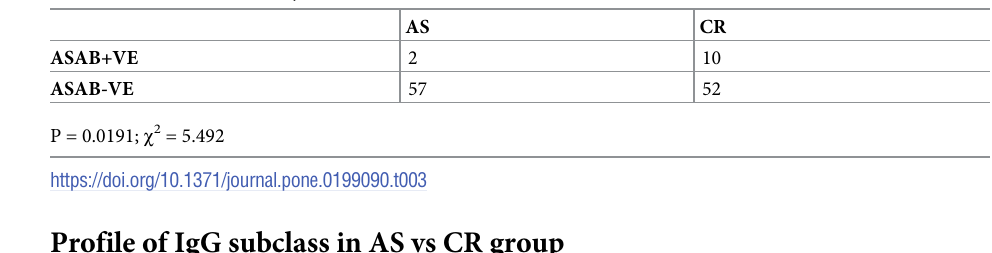
Table 3. Anti-sheath antibody between AS and CR cases.